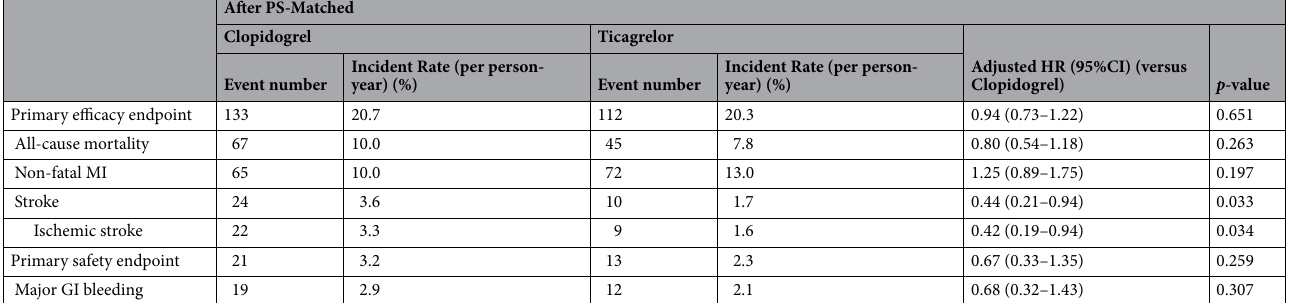
Table 3. Efficacy and safety outcomes of NSTEMI after propensity score